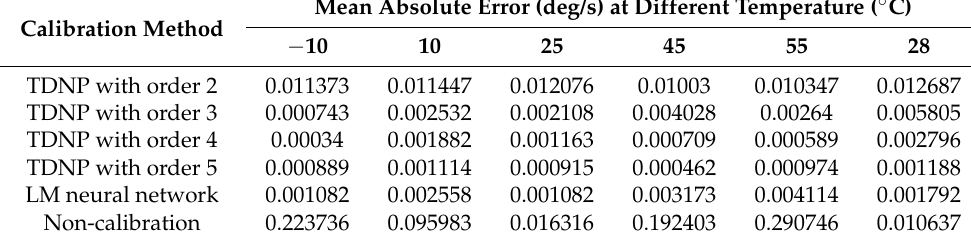
Table 1. Mean absolute error of different methods (070076).